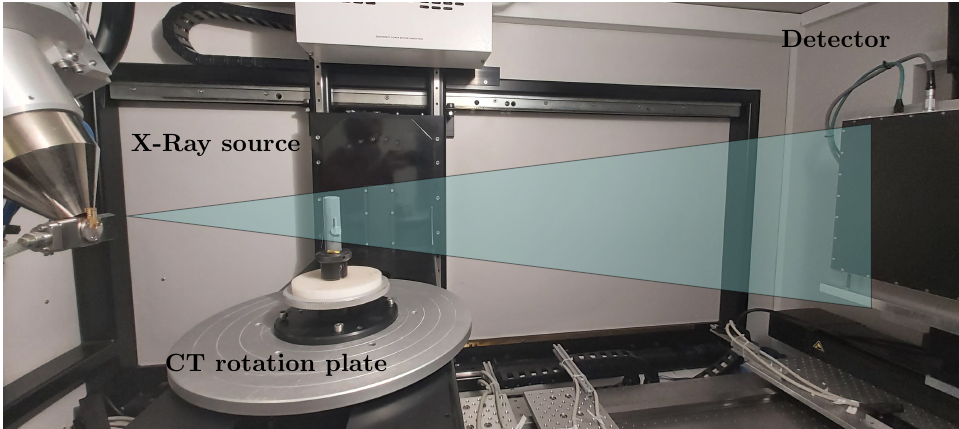
Figure 3. Computed tomography setup for 3D measurement of the battery cell for different loading conditions to compare the mechanical structure of the cylindrical